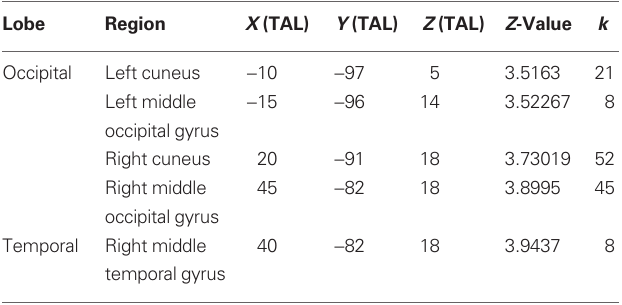
Table 5 | Electroencephalography activation differences specific to [correct > tool] > [incorrect > tool] from 300 to 400 ms following image